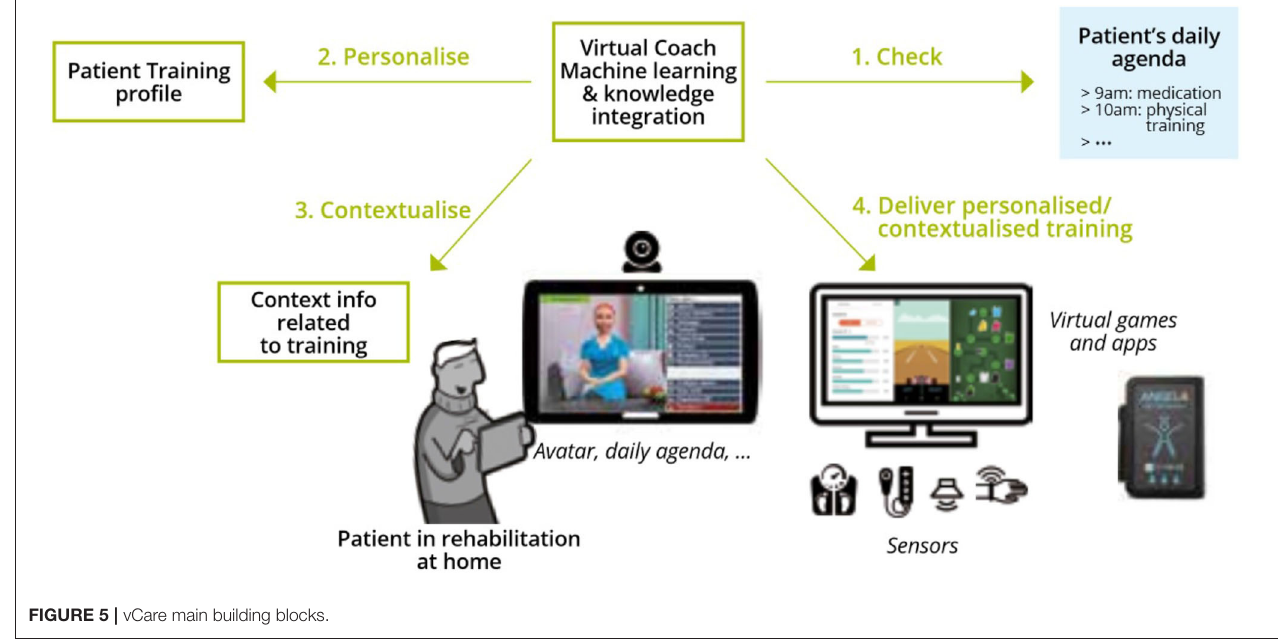
FIGURE 5 | vCare main building blocks.